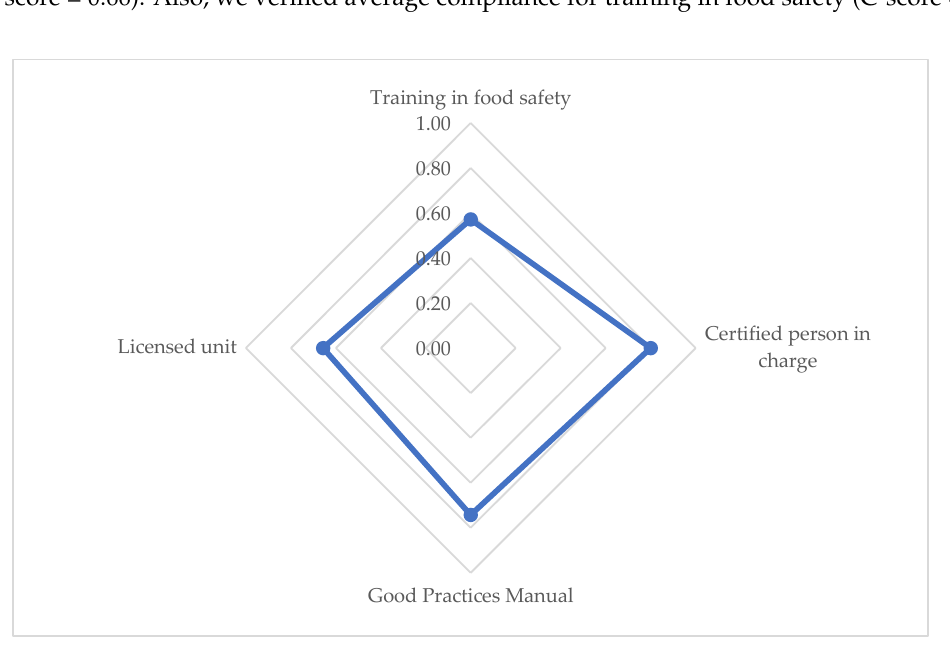
Figure 2. Compliance scores of food safety rules.